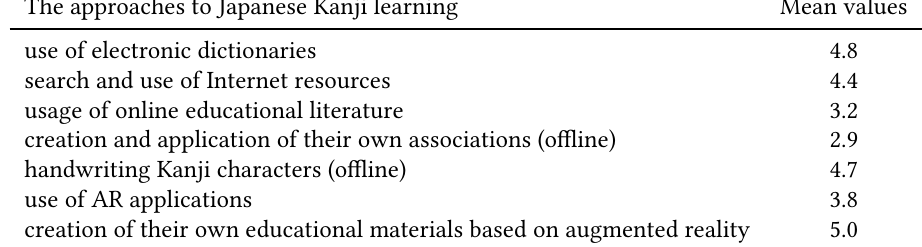
Results of students’ questionnaires on their opinion on the choice of approaches to the Japanese Kanji characters